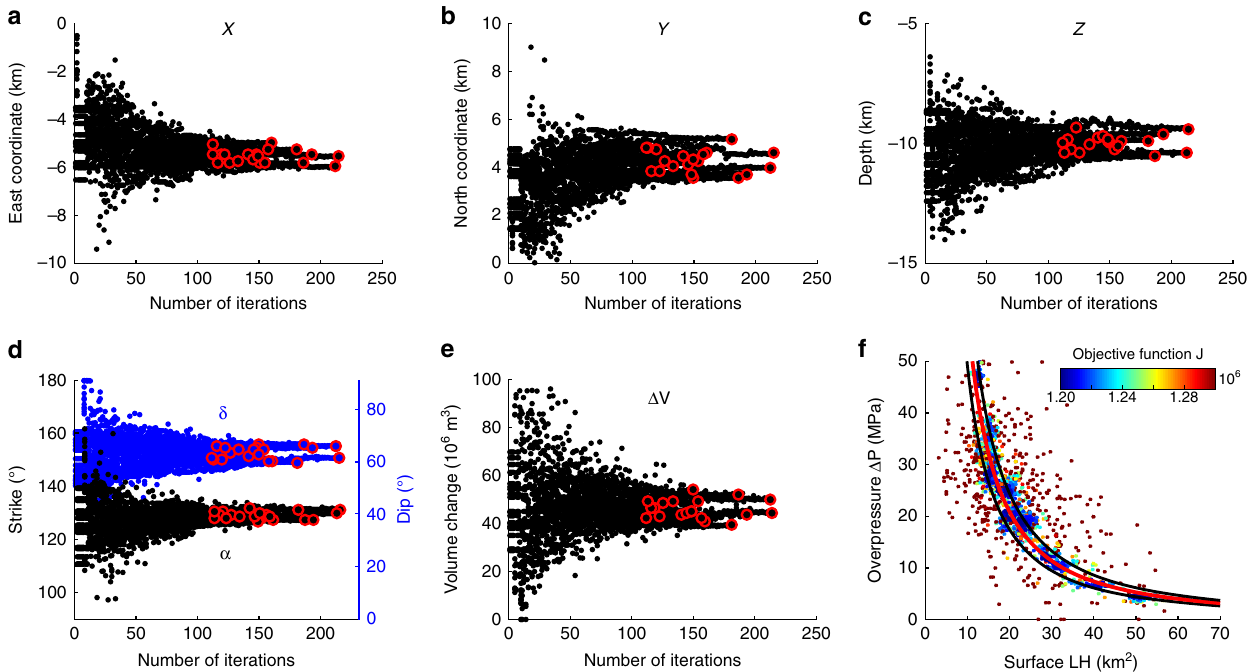
Fig. 9 Parameters convergence and trade-off for the intrusion model. The non-linear joint inversion of ascending and descending InSAR cumulative stacks is performed using COMSOL Multiphysics. The convergence is obtained for a East coordinate, b North coordinate, c Centre depth, d Strike and Dip and e Volume change. Red circles correspond to the optimal values found after the set of 20 Nelder − Mead optimizations: the average and standard deviation values for each parameter are shown in Supplementary Table 3. f Parameter trade-off between the surface area of the intrusion and the magma overpressure. The red line shows a power-law function corresponding to the optimal volume change of 47.6 × 10 6 m 3 and the black lines